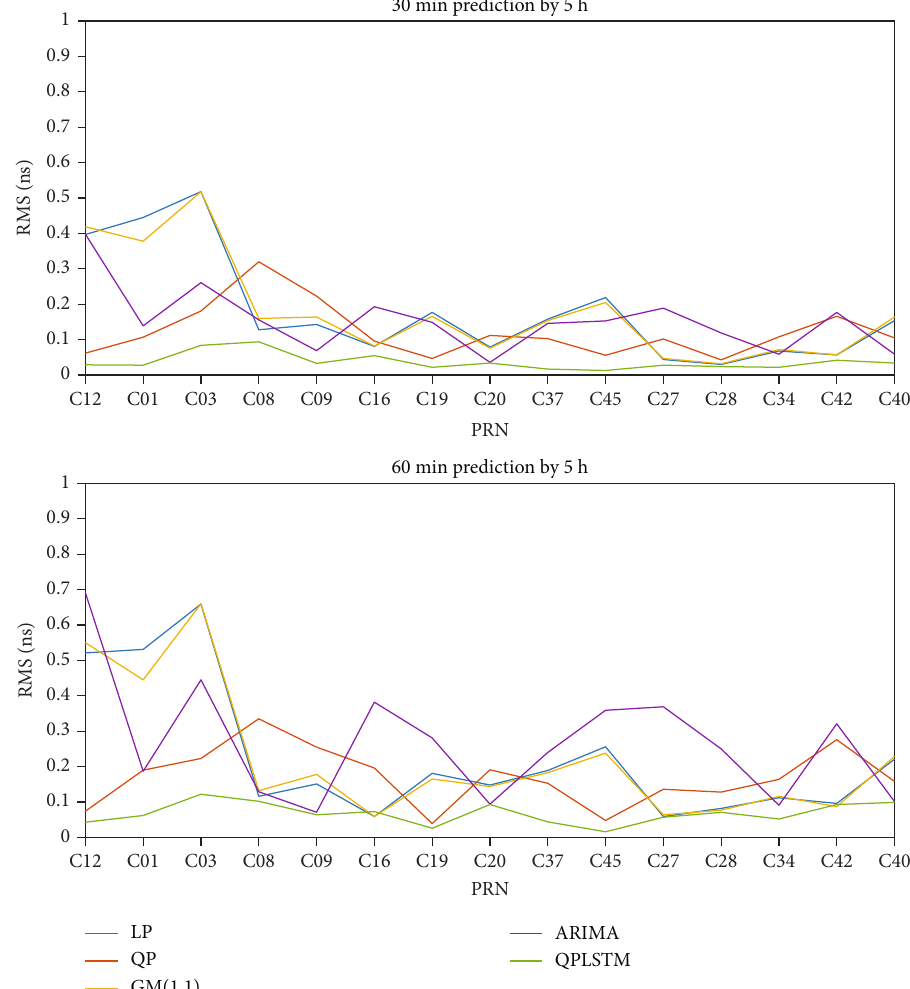
Figure 9: Prediction precisions of the fi ve models for 30 min and 60min forecasting for each BDS satellite. Table 3: 30min and 60min average prediction RMS for six di ff erent clock categories based on the fi ve models for 1h. Clock